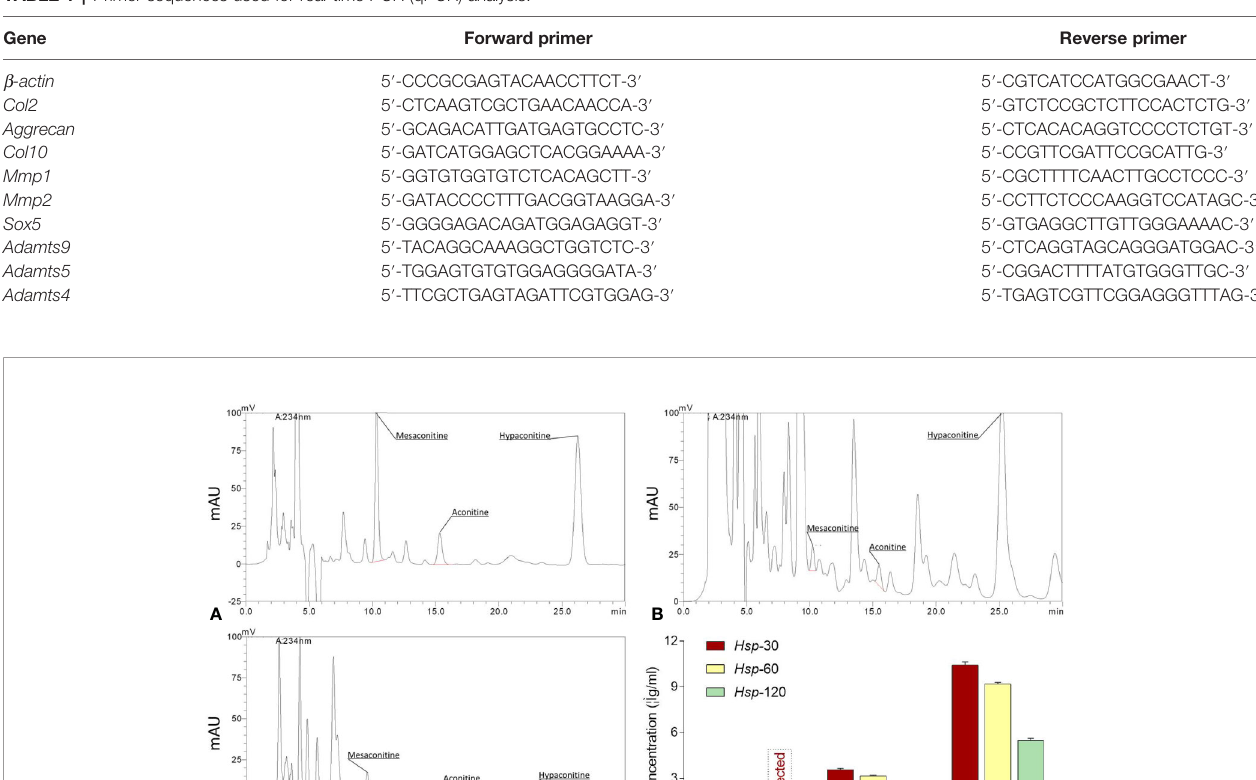
TABLE 1 | Primer sequences used for real-time PCR (qPCR)